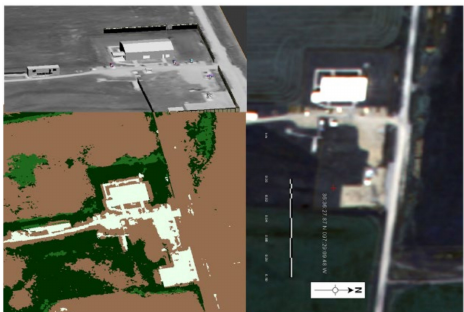
Figure 3. Computer-aided design (CAD) model ( upper left ), WorldView-3 image ( right ), and simulated image ( lower left